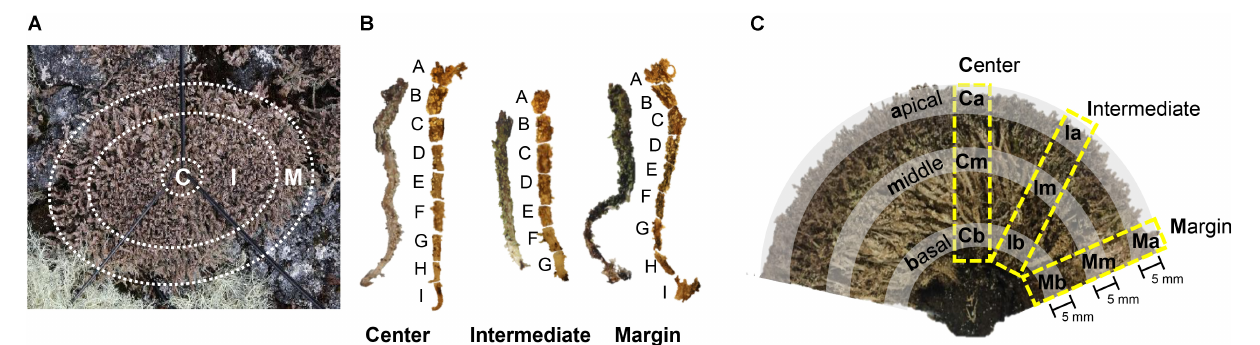
FIGURE 1 | Sample preparation of Cladonia squamosa for microbiome analyses. (A) Top view of the lichen colony. Thalli were collected from central (C), intermediate (I), and marginal (M) positions. Central position was within 2 cm from the center of the colony and marginal position was within 2 cm from the edge of the colony. (B) Each thallus was sectioned by 3–5 mm interval for fine-scale microbiome analysis. (C) Side view of the sectioned lichen colony. Lichen thalli were collected from the Central, Intermediate, and Marginal positions in the colony and subsamples were prepared from the apical, middle, and basal parts of each thallus for statistical